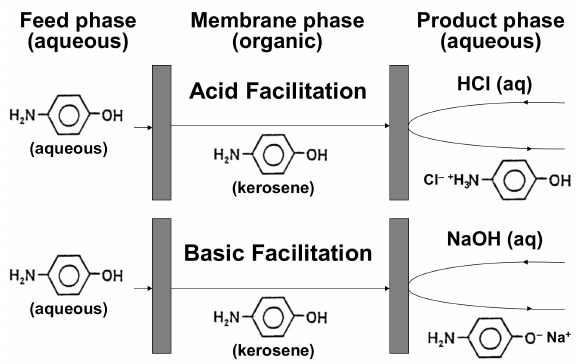
Figure 1. Acid and basic type 1-facilitated transports of 4AP through liquid